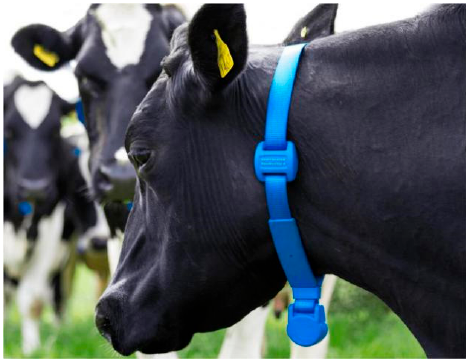
Figure 3. Smart collars (Source: DAIRYMASTER).